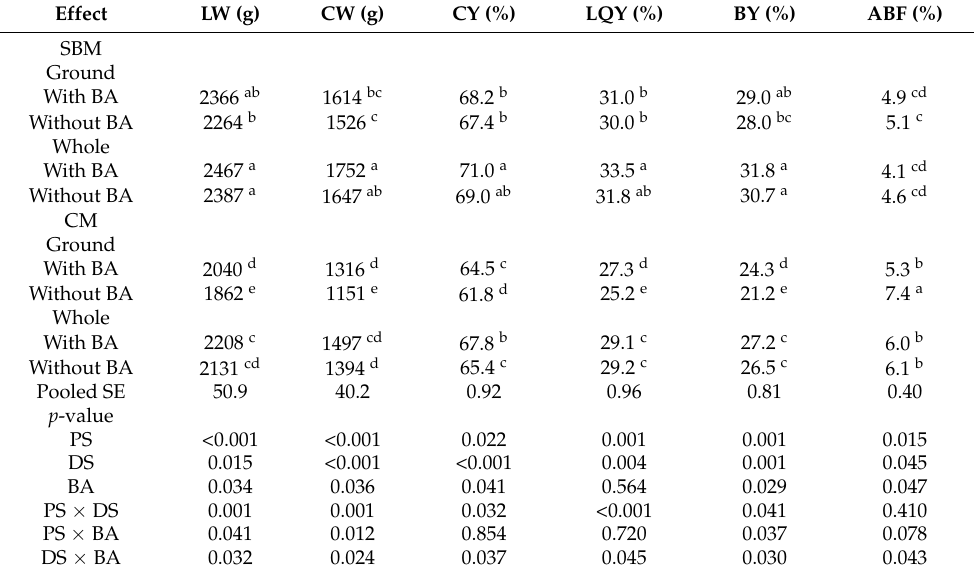
Table 6. Effects of protein source (PS), diet structure (DS) and butyric acid (BA) supplementation on carcass characteristics 1 in broilers 2 at 36 days of